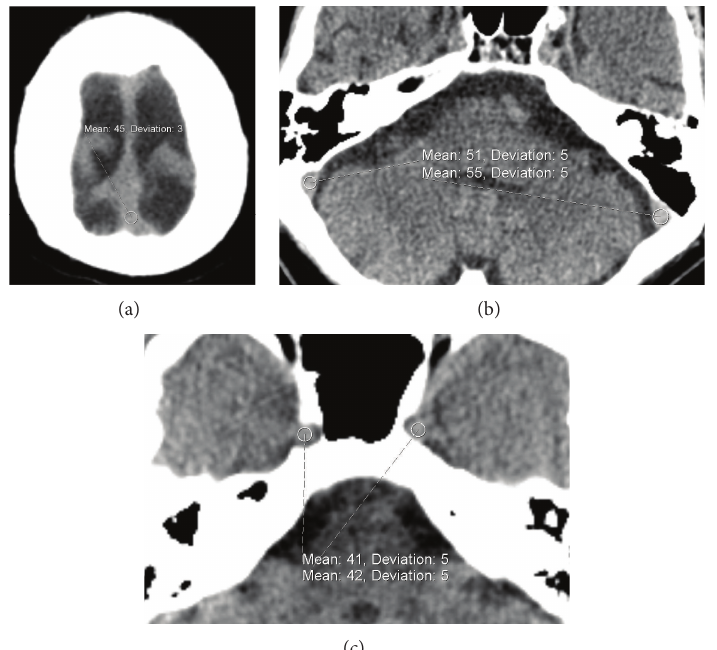
Figure 1: Images from NCT demonstrating sites of HU measurements from (a) superior sagittal sinus at the vertex, (b) sigmoid sinus, and (c) intracranial ICA just distal to the carotid canals.